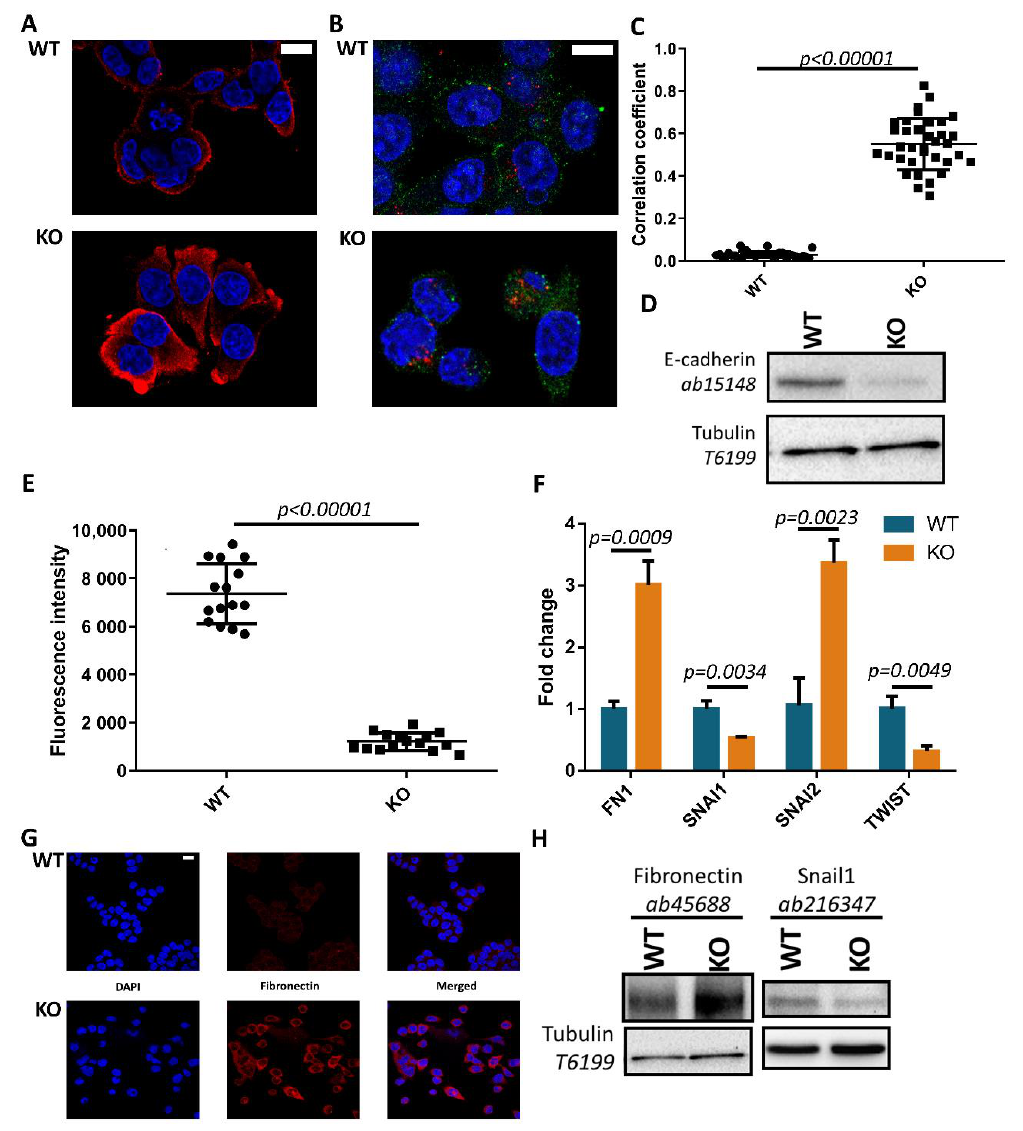
Figure 2. Loss of Tks4 induces morphological changes and altered expression levels of epithelial to mesenchymal transition (EMT) markers. ( A ) E-cadherin (red) staining of wild type and Tks4-KO cells. The nuclei were visualized with DAPI (blue), and the scale bars represent 20 µm ( B ) Staining of E-cadherin (green) and acidic lysosomes (red, LysoTracker™ Dnd-99). The nuclei were stained with DAPI, and the scale bars represent 20 µm. ( C ) Co-localization analysis of the E-cadherin and the lysosomal signals. The center lines show the medians, and the end lines indicate the 25th and 75th percentiles, n = 38. Student’s unpaired t-test was used for the statistical analysis. ( D ) Investigation of the E-cadherin protein levels via Western blotting. ( E ) Cellular adherence measurements. Center lines show the medians and the end lines indicate the 25th and 75th percentiles, n = 15. Student’s unpaired t-test was used for the statistical analysis. ( F ) Quantitative PCR analyses of the relative expression levels of the EMT-governing transcription factors Snail1 (SNAI1), Snail2 (SNAI2), and Twist (TWIST), and the mesenchymal marker protein fibronectin (FN1). The error bars show the standard deviation, and Student’s unpaired t-test was used for the statistical analysis. ( G ) Fibronectin (red) staining of wild type and Tks4-KO HCT116 cells. The nuclei were stained with DAPI (blue), and the scale bar represents 20 µ m. ( H ) Investigation of the E-cadherin protein levels via Western